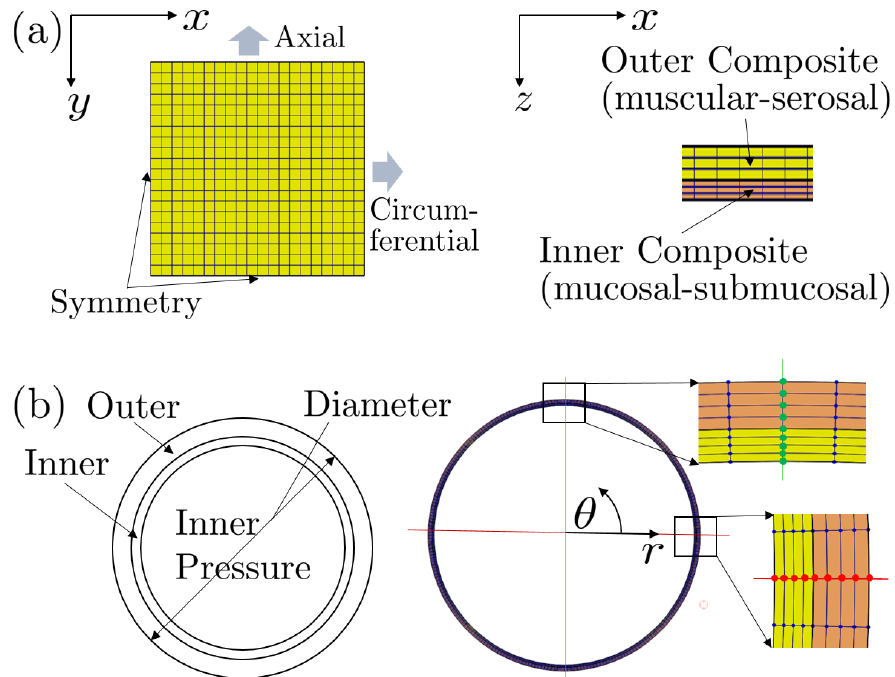
Figure 1. Finite element analyses for validation: ( a ) Biaxial extension test of the bulk coloretum via a two-layered, residually stressed specimens. The specimens have dimensions of 3.5 × 3.5mm 2 based on the symmetry boundary conditions, and biaxial load is applied through the linearly increased circumferential and longitudinal (axial) displacements. ( b ) Pressure-diameter test of the colorectum under applied intraluminal pressure via a two-layered, residually stressed tubular segments. Exploiting plane-strain conditions we modeled only 2mm longitudinal segments of intact colorectums, and applied symmetry boundary conditions and fixed two radial rows of nodes normal to the radial direction (to prevent rigid-body rotations). We axially stretched the model by 30%, consistent with the experiments ex vivo, and the linearly increased intraluminal pressure from 0 to 100mmHg